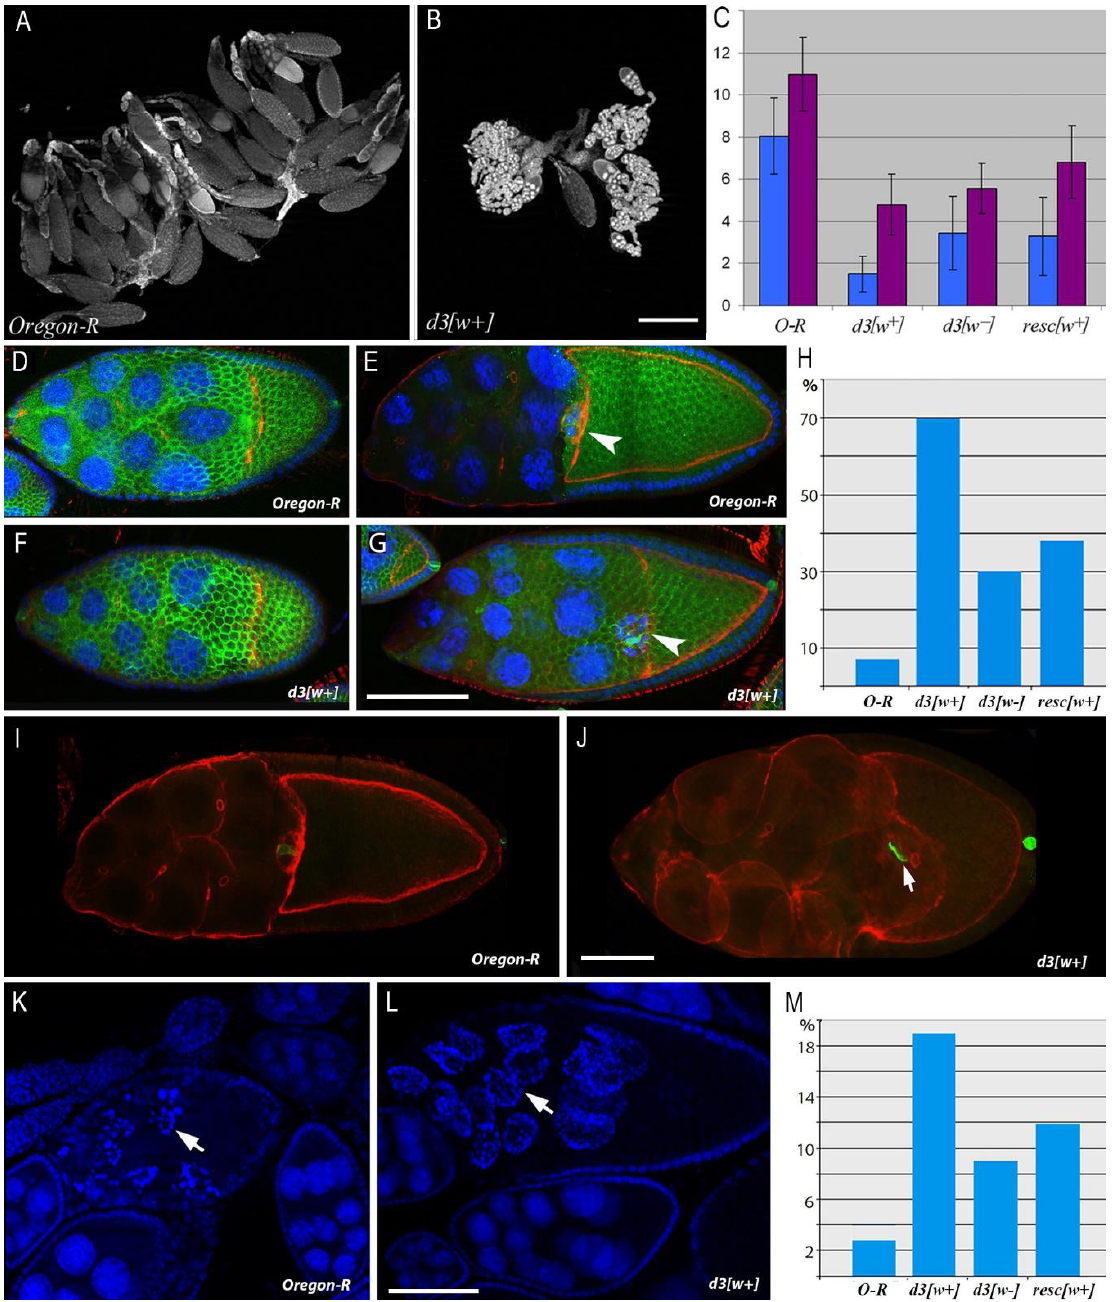
Figure 2. Comparative analysis of egg formation aberrations and oogenesis abnormalities caused by mutations in the 5 ′ region of Notch . ( A , B ). Ovary morphology in 3-day-old females of genotypes Oregon-R ( A ) and d3[w+] ( B ). ( C ). The egg number in the ovaries of 3-day-old (blue) and 5-day-old (pink) females. The bars denote the number of eggs in an ovary (mean ± SD; n = 40). Differences from the control ( Oregon-R ) are significant at p < 0.05. ( D – G ). Alteration of egg chamber (EC) morphology at stages 9–10A in the mutant background compared to the wild type. ( D , E ). In Oregon-R females,